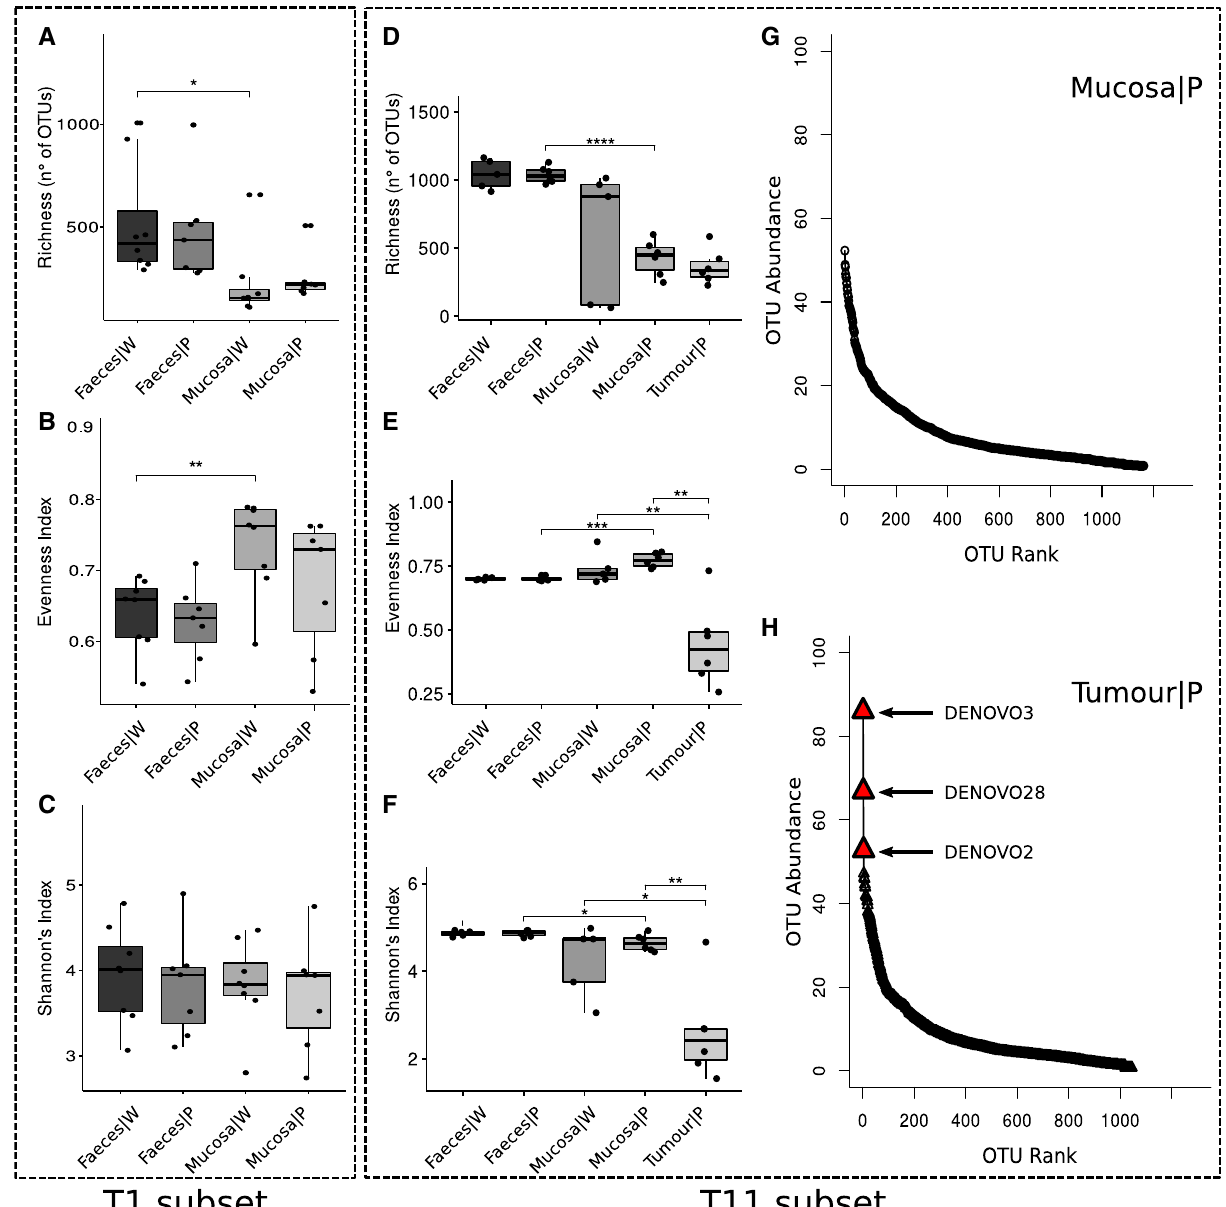
Figure 1. Diversity analysis of bacterial communities in rats, calculated by number of observed OTUs, Pielou’s Evenness, Shannon and Simpson indices. ( A ) Differences in observed Richness between samples groups at T1 assessed with t-test (*p-value < 0.05). ( B ) Differences in Evenness diversity index between samples groups at T1 assessed with t-test (**p-value < 0.01). ( C ) Differences in Shannon’s diversity index between samples groups at T1 assessed with t-test. ( D ) Differences in observed Richness between samples groups at T11 assessed with t-test (****p-value < 0.0001). ( E ) Differences in Evenness diversity index between samples groups at T11 assessed with t-test. (**p-value < 0.01; ***p-value < 0.001). ( F ) Differences in Shannon’s diversity index between samples groups at T11 assessed with t-test (*p-value < 0.05; **p-value < 0.01). ( G ) Rank abundance curves of mucosal samples at T11 in Pirc rats. ( H ) Rank abundance curves of tumour samples at T11 in Pirc